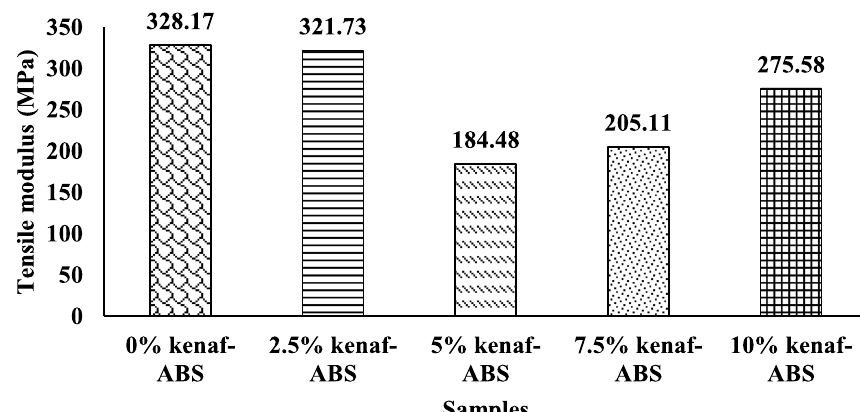
Fig. 4 Tensile modulus for kenaf–ABS composites